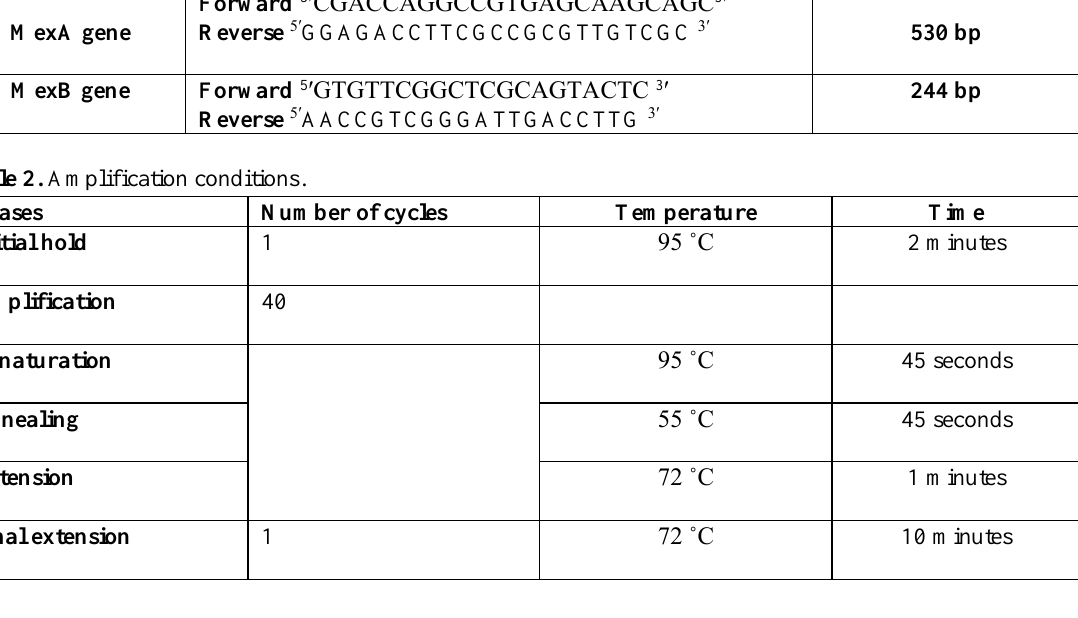
Table 3. Association between antimicrobial resistance pattern and MexA/MexB